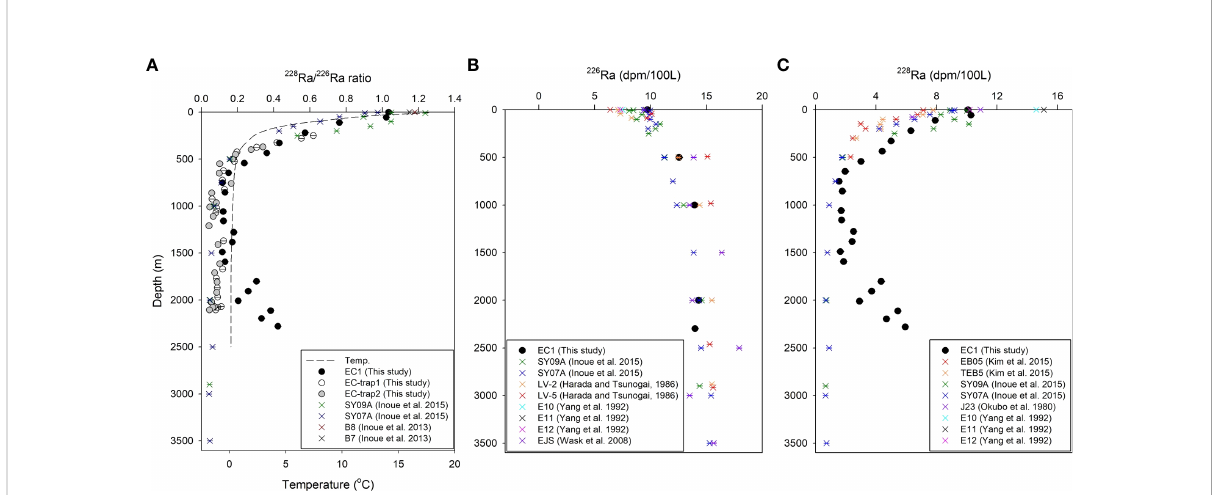
FIGURE 2 Depth pro fi les of (A) 228Ra/226Ra ratios (B) 226 Ra, and (C) 228 Ra at stations EC1, EC-trap1, EC-trap2, and other stations from previous studies. The bottom depth at station EC1 is 2313